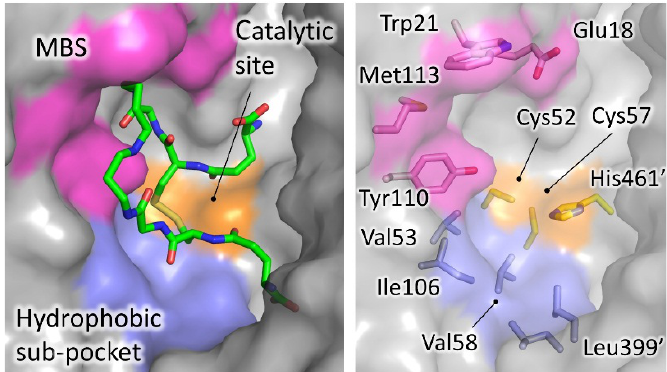
Figure 4. Trypanothione binding cavity. Surface representation of TR from T. brucei (pdb: 2wow). The most significant areas for ligand interaction are highlighted with different colors. TS 2 , extracted from T. cruzi structure (pdb: 1bzl) is shown as sticks.